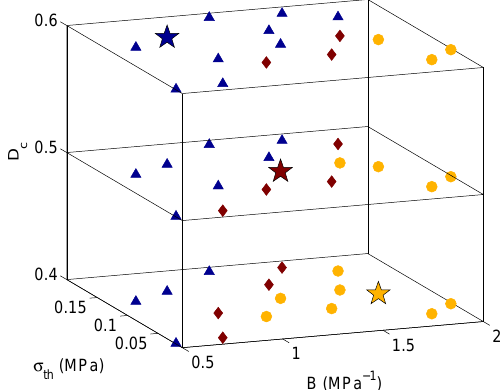
Figure 7. Parameters set for the damage model discriminated by B , σ th , D c . Blue triangles represent simulations in which the position of the front exceeded 350km and yellow circles represent simula- tions in which the front retreated less than 340km. Red diamonds identify the successful simulations. Colored stars correspond to the three parameter sets illustrated in Fig.